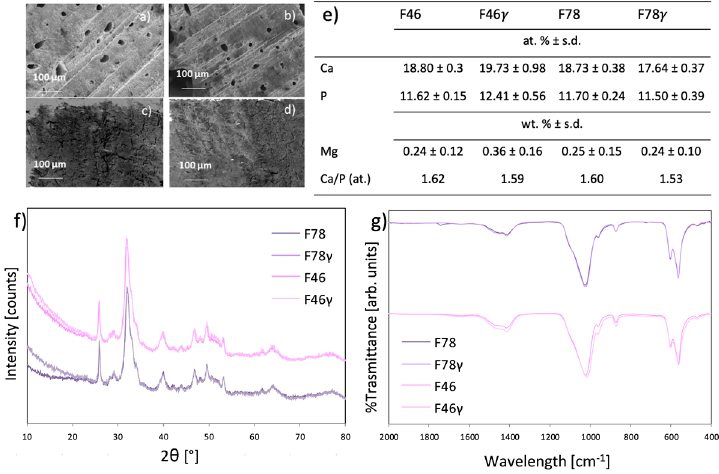
Figure 3. Representative SEM images of human samples F46 ( a ), F46 γ ( b ), F78 ( c ), F78 γ ( d ) and ( e ) EDS elemental composition, ( f ) FT-IR and ( g ) XRD spectra of the irradiated and not irradiated samples.